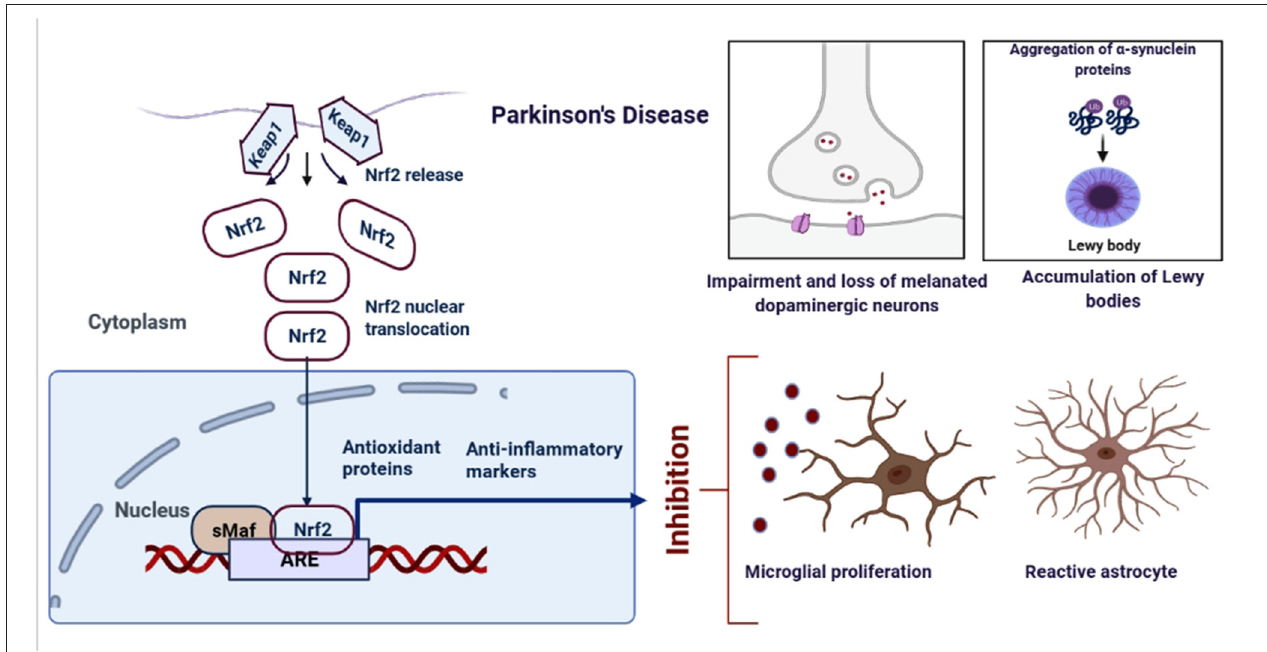
FIGURE 3 | Schematic representation of the role of Nrf2 in PD. An upregulation in the dopamine release could result into the oxidative stress, increased ROS production and neuroinflammation. However, when astrocytes and microglia produces Nrf2, it activates the antioxidant and anti-inflammatory gene expressions.